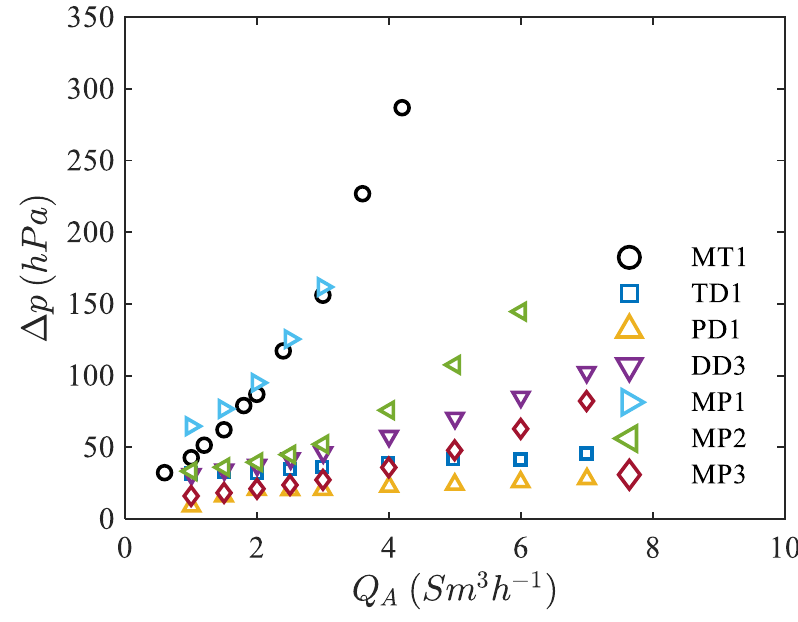
Figure 7. Pressure drop versus standard gas flow rate for various diffusers.